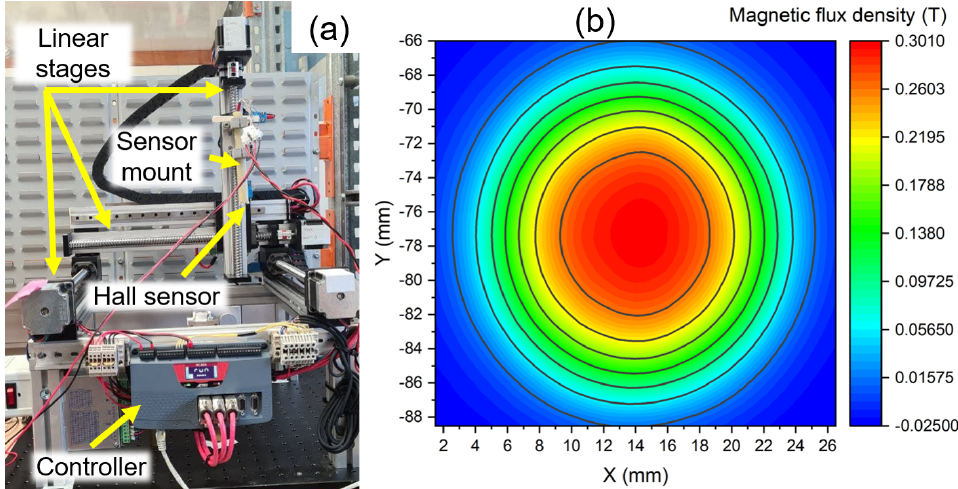
Figure 2. The magnetic field measurement setup ( a ), and the magnetic field of the 17 mm PM at 2.5 mm distance from its surface ( b ).